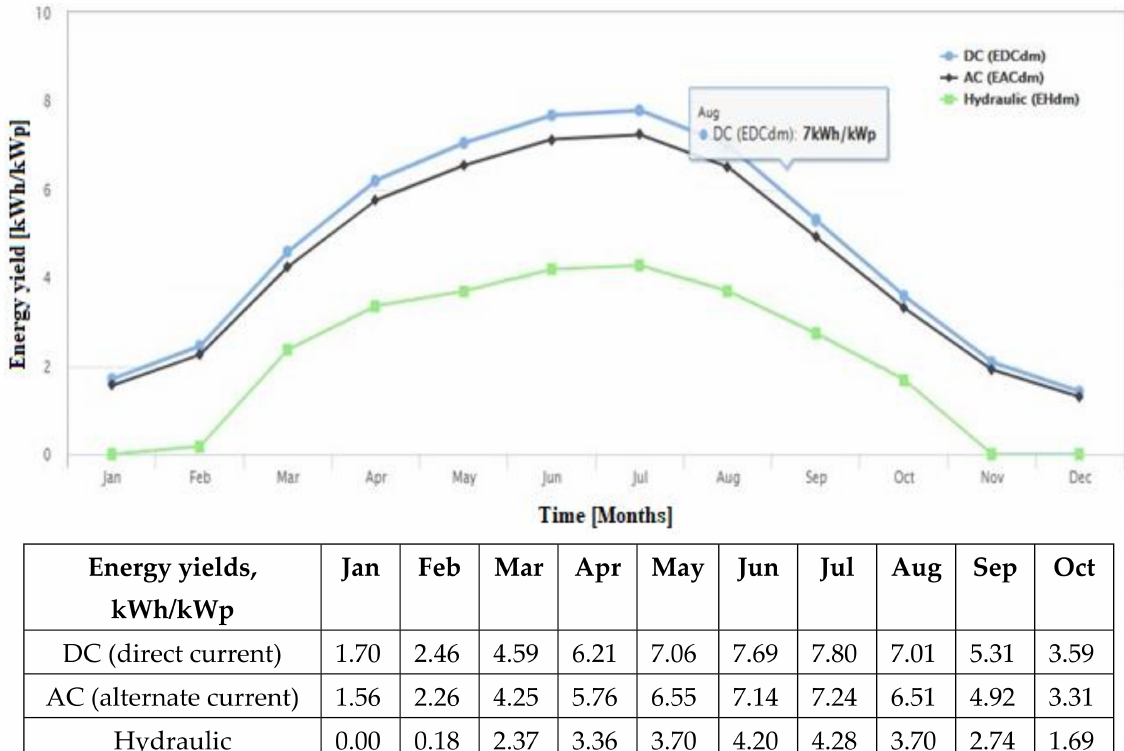
Figure 10. Monthly energy yield of the PV pumping system irrigation (a specific site, South of